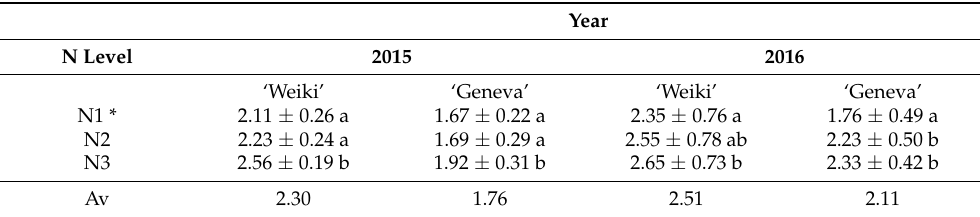
Table 1. Leaf N concentration (% DW) in relation to year, cultivar, and soil N level. Data are means over the season (leaf samples were collected at five time points) ± SD (n =